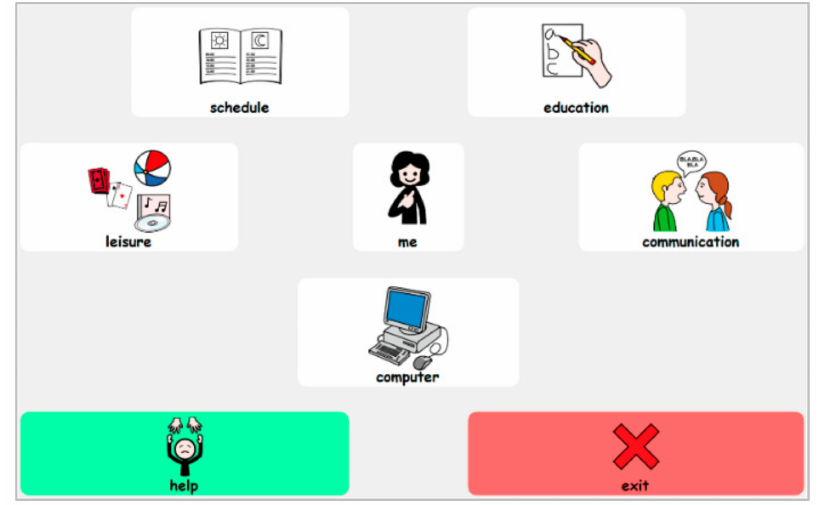
Figure 2. The main screen of the ASD